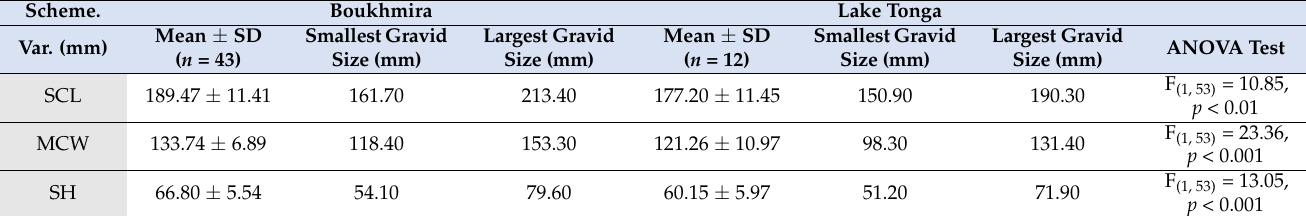
Table 1. Morphometric data of sampled gravid females in the two studied habitats. Var: variable; SD: standard deviation; n = sample size; SCL: straight midline carapace length; MCW: mid-body